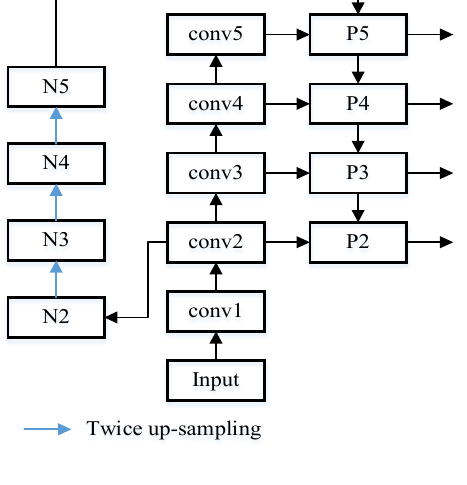
Figure 8. Skip-FPN module